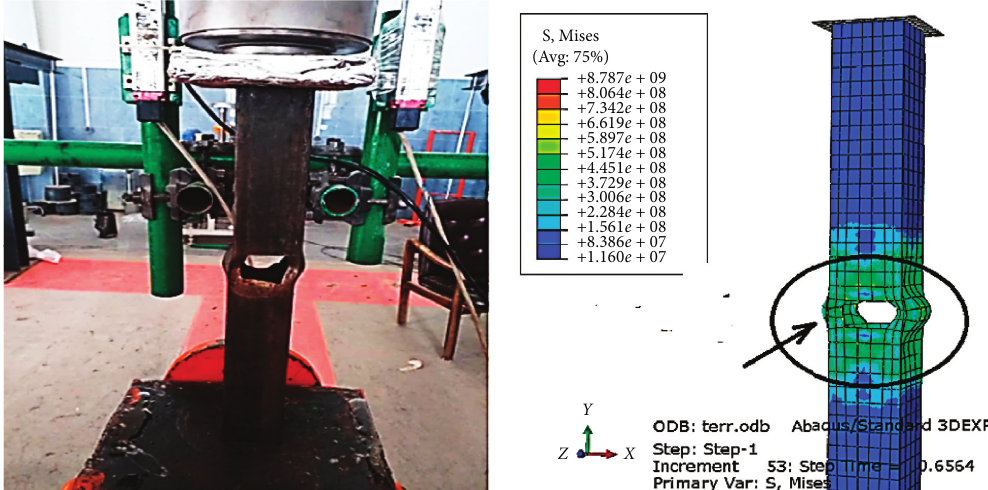
Figure 14: Comparison of a sample with defects in two walls in front of a short steel column [33].